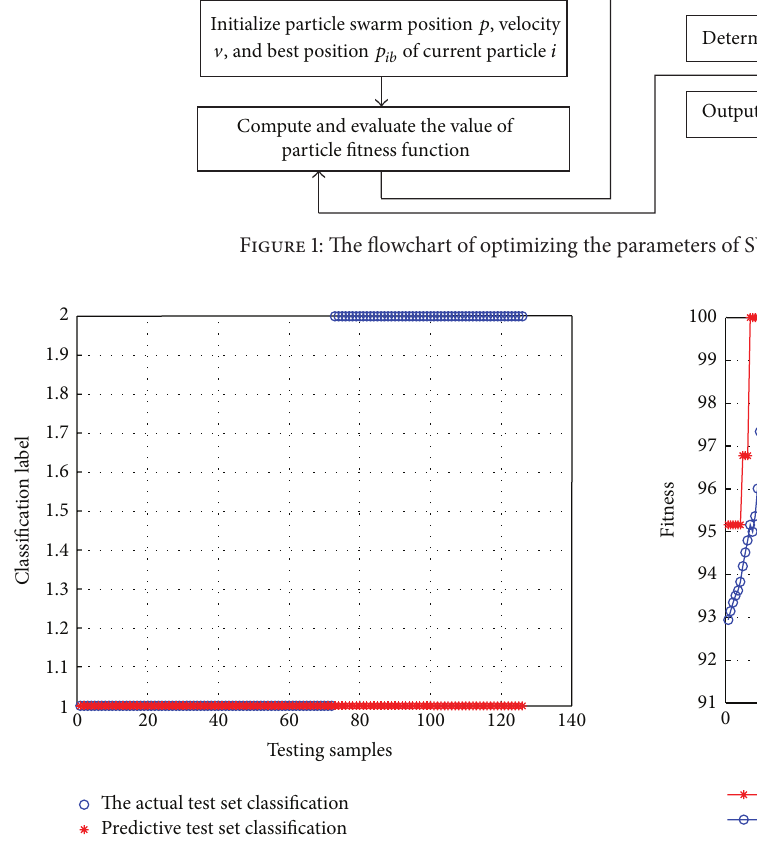
Figure 2: The classification result of the SVM model.